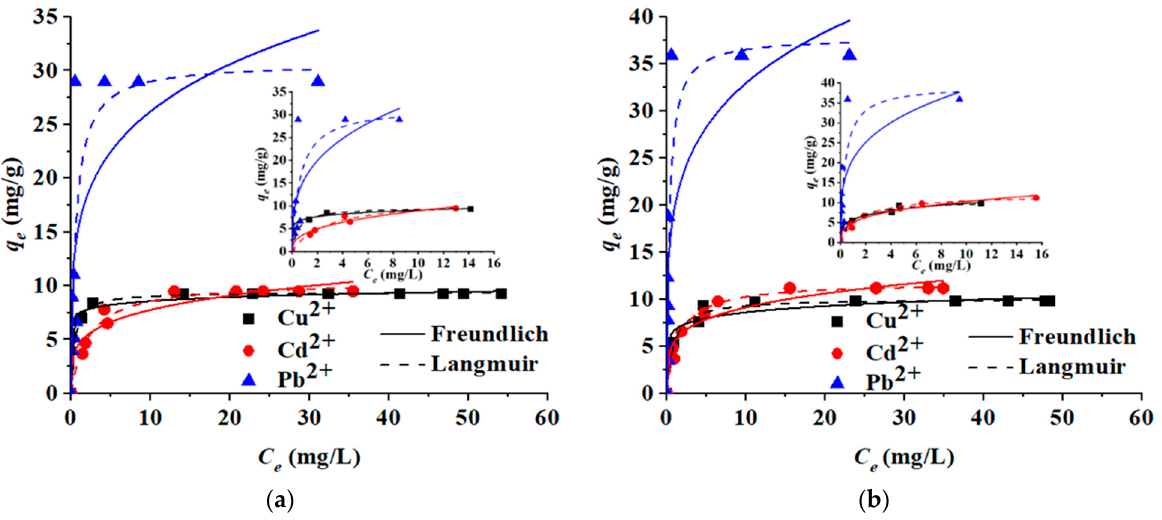
Figure 5. Adsorption isotherms of heavy metal cations (Cu 2+ , Cd 2+ , Pb 2+ ) onto the solid surface of oxidized wool fibers: ( a ) adsorption isotherms recorded at 300 K; ( b ) adsorption isotherms recorded at 323 K; solid lines represent predictions given by the Freundlich model, and dash lines represent predictions given by the Langmuir model.